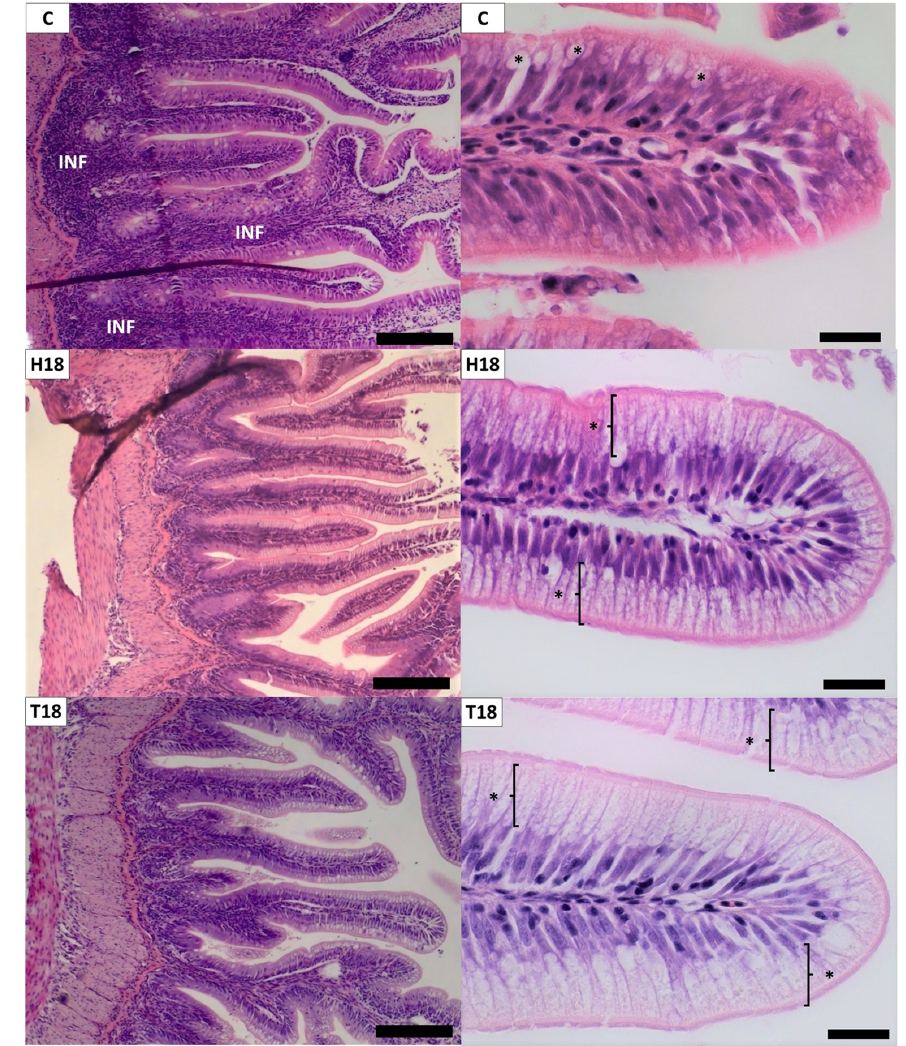
Figure 2. Histomorphology of rainbow trout distal intestine. C: control diet (no IM inclusion); H18: 18 % HI inclusion; T18: 18 % TM inclusion. Microphotographs of qualitative analyses: left photographs represent a comparative view of inflammatory infiltration (INF), pictures taken at 40 × magnification, scale bars = 100 μ m; right photographs represent a comparative view of vacuoles (marked with asterisks) in enterocytes, pictures taken at 400× magnification. Scale bars = 10 μ m. Few significant differences were found in pyloric caeca compared to the distal intes ‐ tine. T18 showed the highest values for villi height (compared to H18; p < 0.05), while the